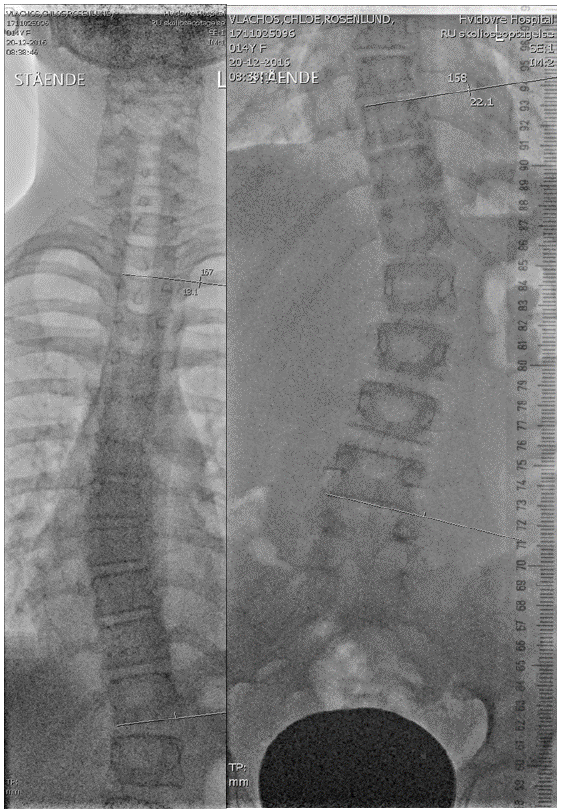
Figure 2. An example of radiographs using the low dose technique.